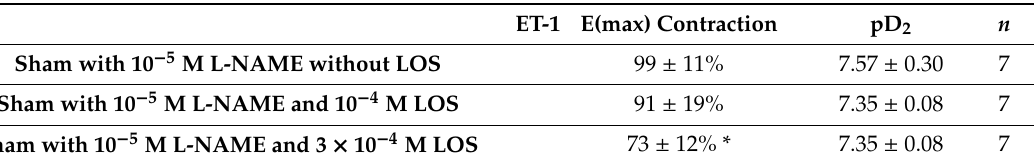
Table 2. Contractile assessment (ET-1) after incubation with L-NAME, a NO-inhibitor, without and with LOS, an AT 1 receptor antagonist, under physiological conditions. ET-1 induced a dose-dependent contraction, which was significantly reduced by LOS. This LOS-dependent e ff ect was dose-dependent as well. Values are expressed as mean ± SD. * p < 0.05 versus without LOS. ET-1 E(max) Contraction